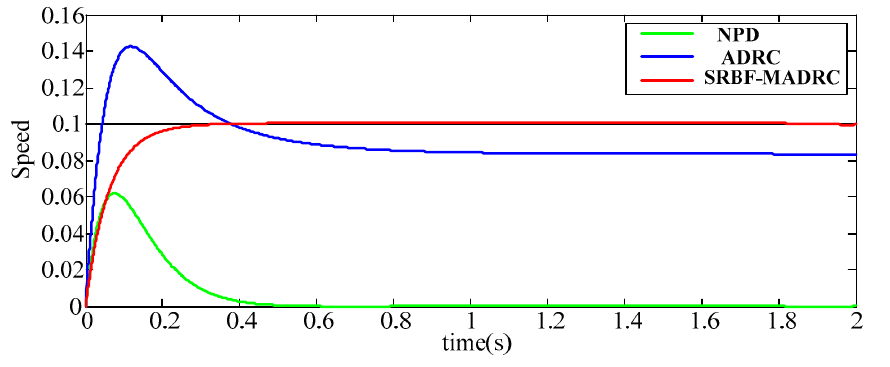
Figure 9. Simulation results of low-speed tracking.